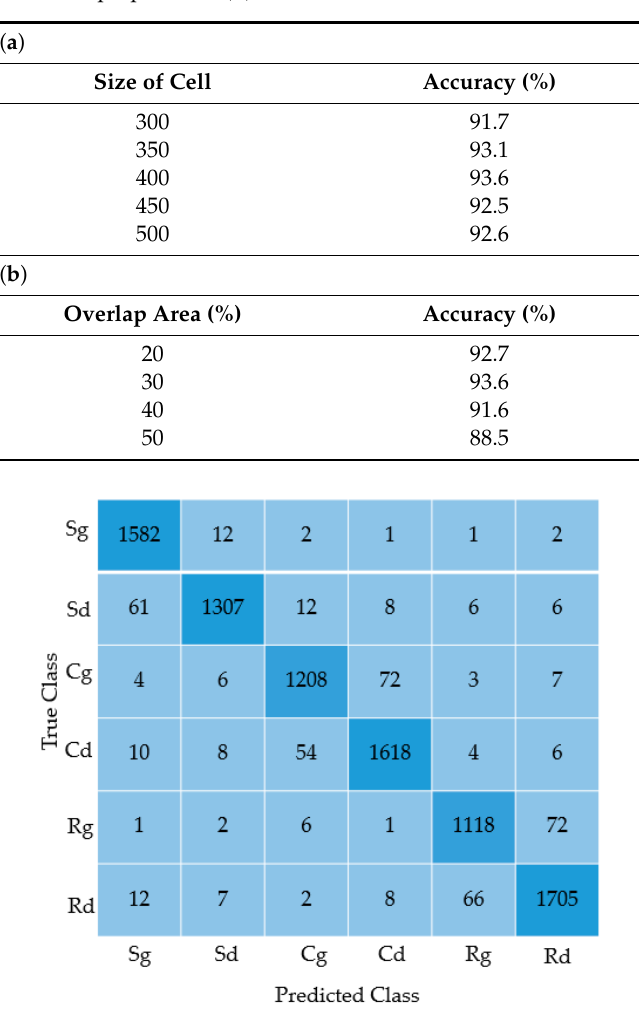
Figure 10. The confusion matrix for results of the 9000 test dataset for three types of defections.